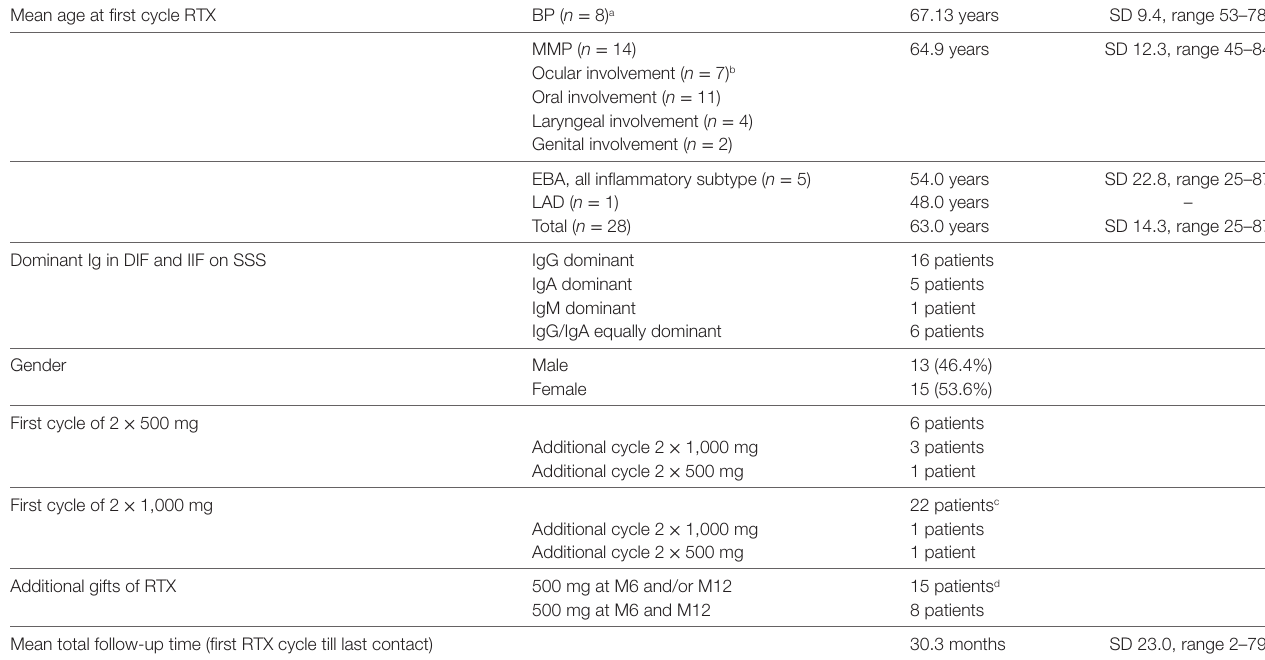
Table 1 | Demographics of pemphigoid patients treated with